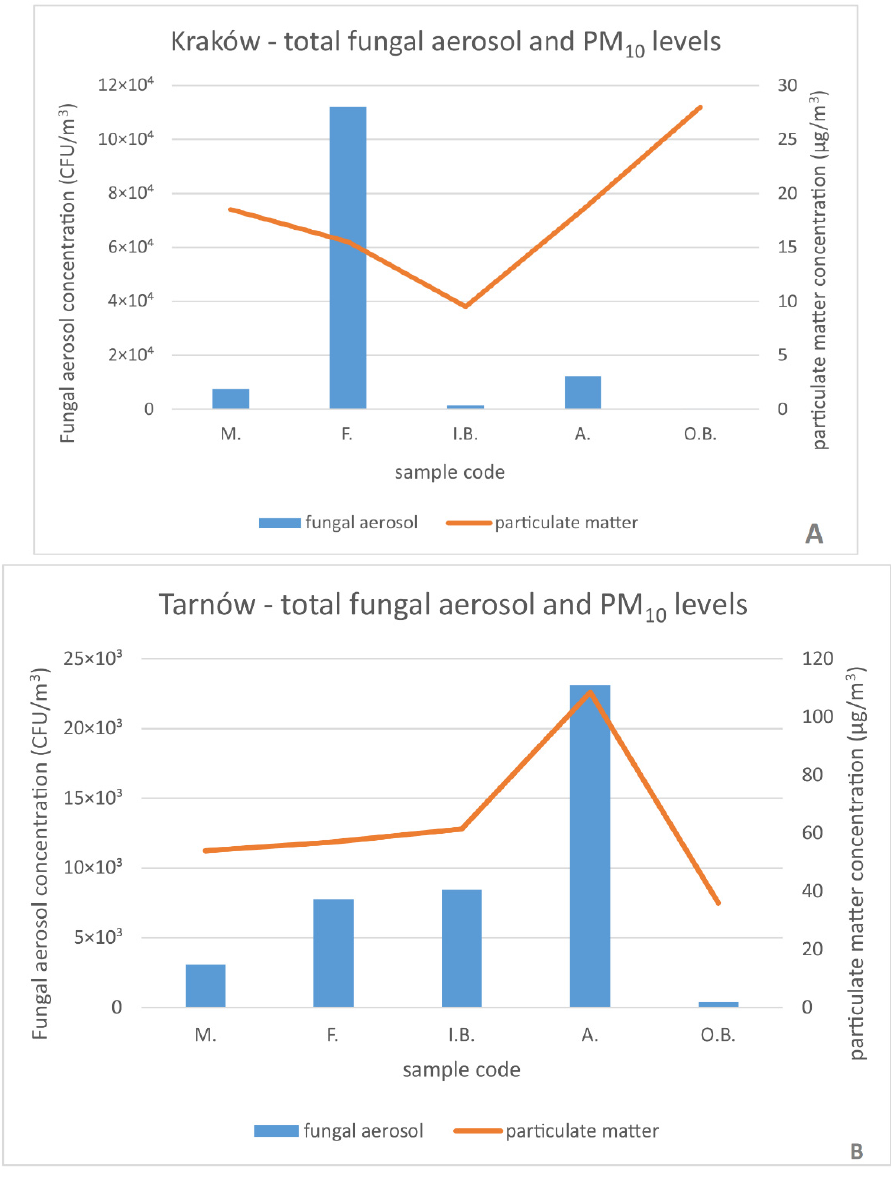
Figure 4. Concentration of total fungal aerosol (CFU/m 3 ) in different times of day compared with the inhalable particulate matter concentration (PM 10 ; µg/m 3 ). Kraków ( A ) and Tarnów ( B ) horse stables.